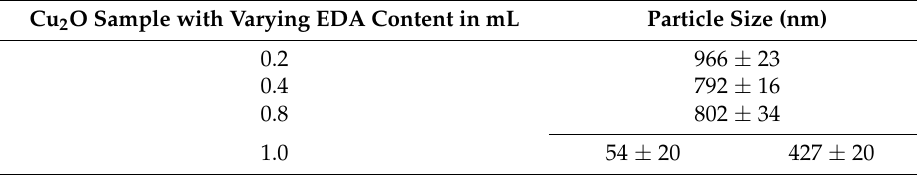
Figure 6. SEM images and size distribution of Cu 2 O nanoparticles with increasing EDA content from ( a , b ) 0.2 mL, ( c , d ) 0.4 mL, ( e , f ) 0.8 mL to ( g , h ) 1 mL. Table 1. Size distribution of Cu 2 O nanoparticles with varying EDA content. Cu 2 O Sample with Varying EDA Content in